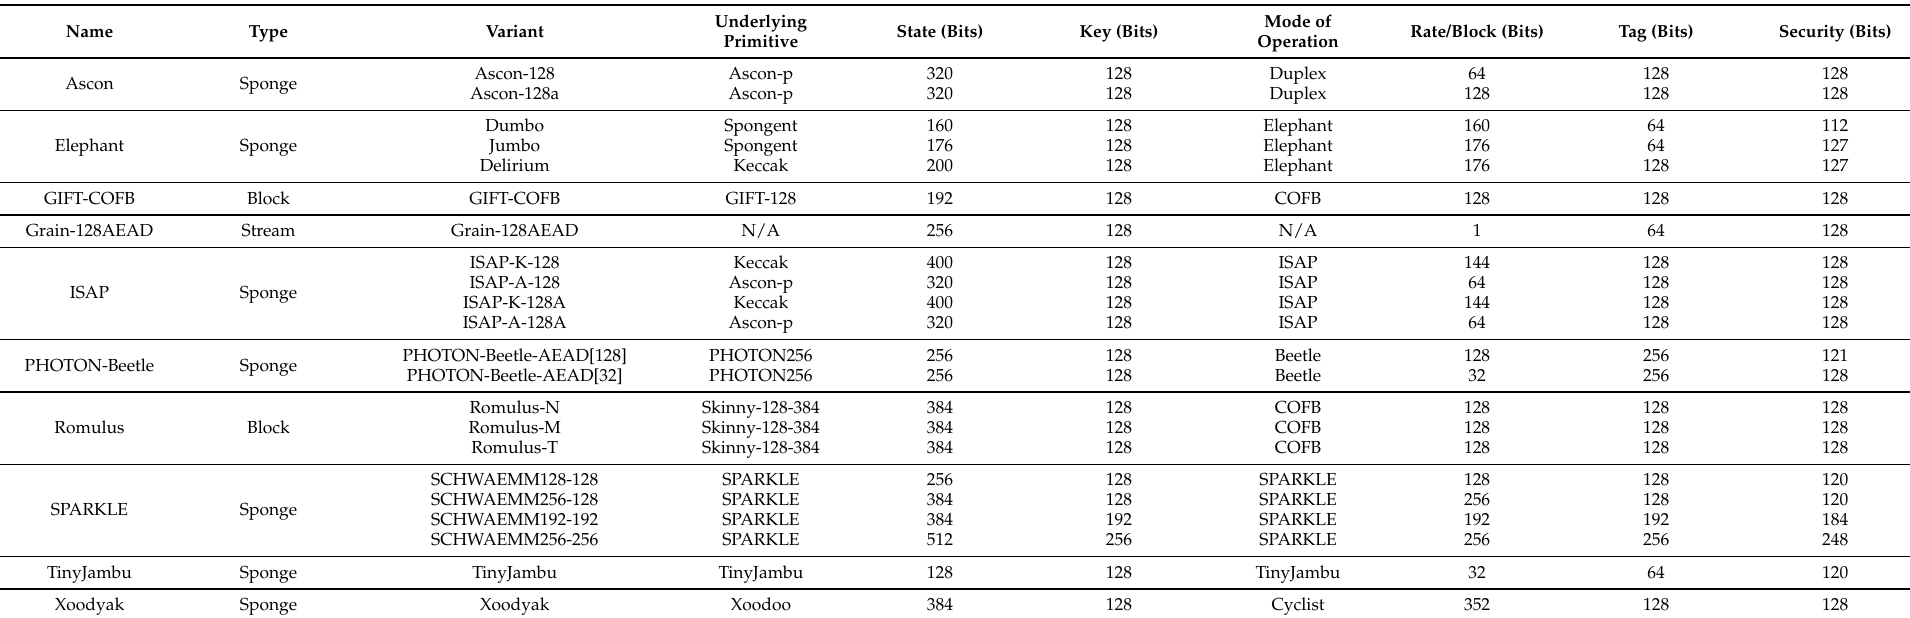
Table 1. A summary of the specifications of the NIST LWC finalist